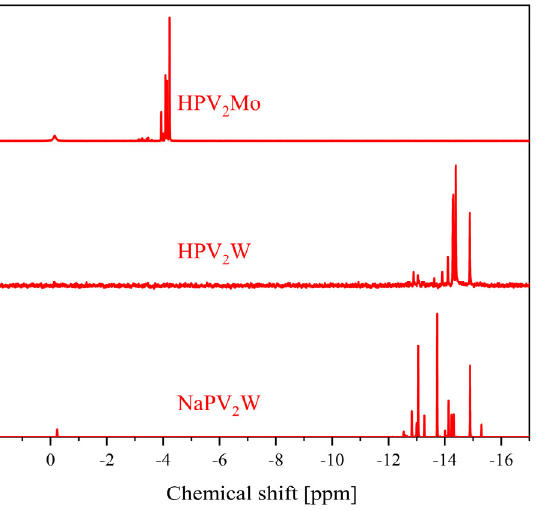
Figure 8. 31 P ‐ NMR spectra of the POMs NaPV 2 W, HPV 2 W, and HPV 2 Mo. Spectra for NaPV 2 W and HPV 2 W were measured in a mixture of 70% water (pH 1) and 30% D 2 O, and spectra for HPV 2 Mo were measured in a mixture of 90% water (pH 1) and 10% acetone ‐ d 6. Measurement frequency: 242.9 MHz; 85% H 3 PO 4 was used as an external standard.